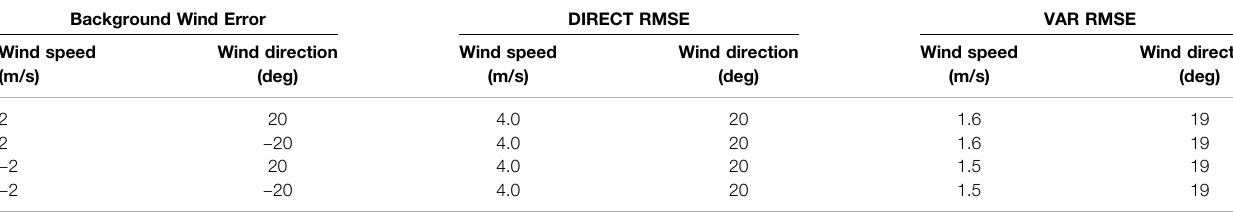
TABLE 4 | Comparison of wind errors by different wind retrieval methods.